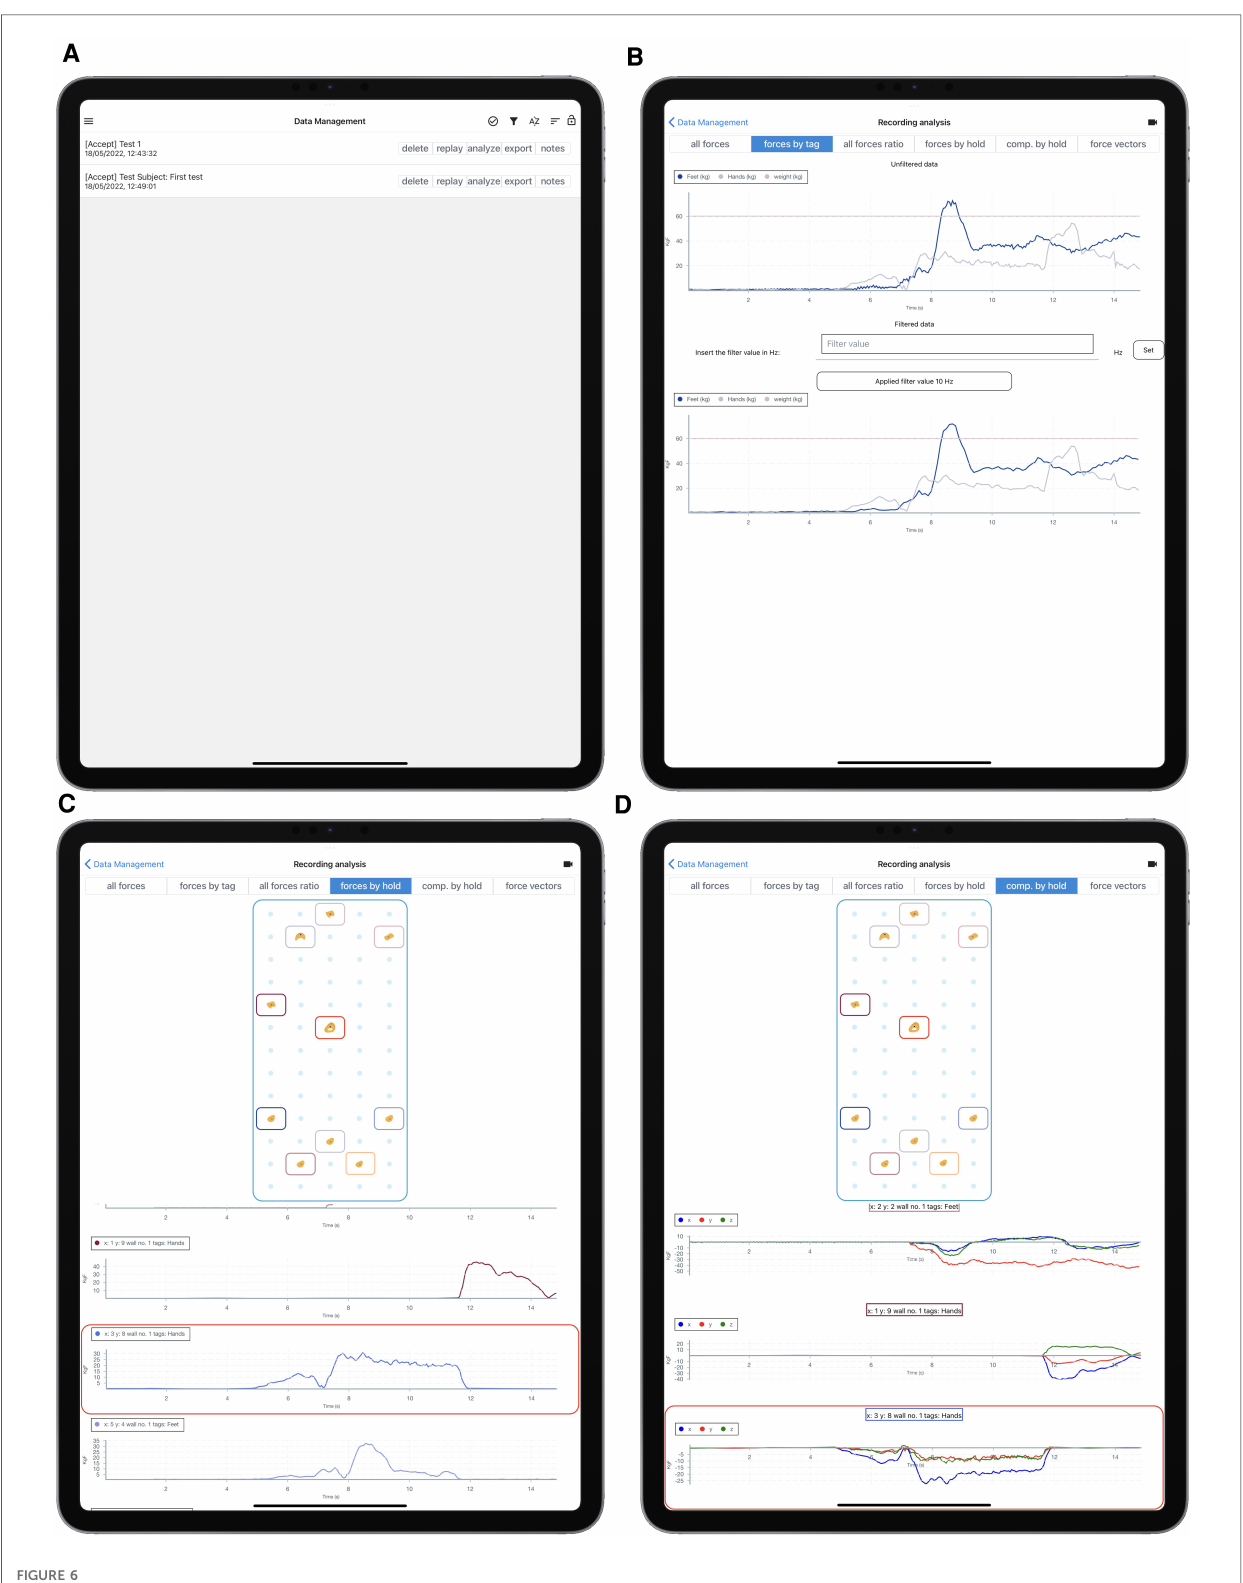
FIGURE 6 Data Management and Recording Analysis environment. Top to bottom and left to right: record selection, visualization of the magnitude of the vector sum of all forces on holds tagged “ hands ” or “ feet, ” compared with climber body weight as inserted in the User Management environment, visualization of the magnitude of the force measured on each hold, visualization of the three components of the force measured on each